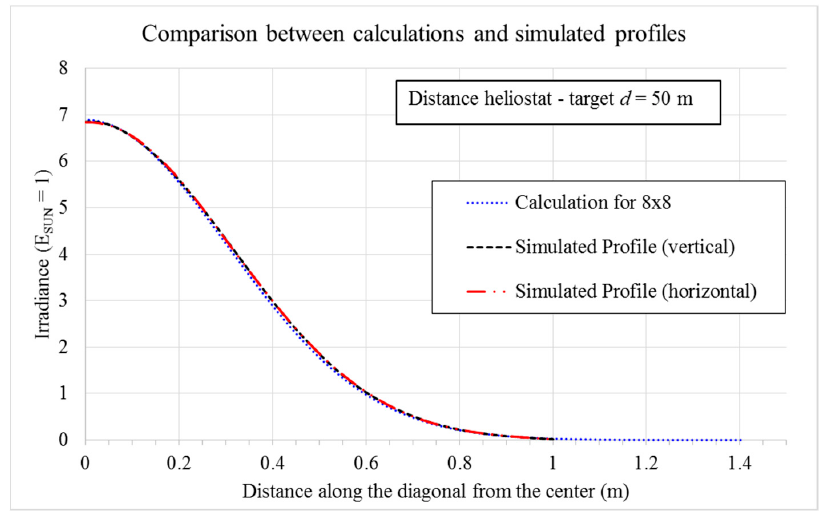
Figure 11. Comparison between simulated irradiance profiles and calculated profile for an 8 × 8 heliostat field.